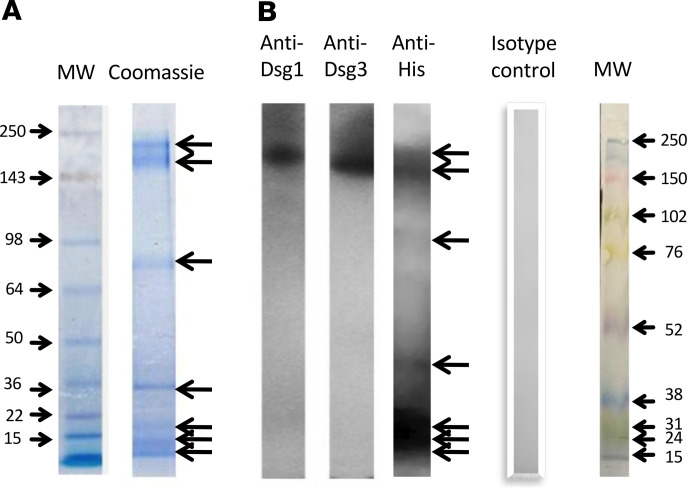
Identification of binding partners of PpSP32 by coimmunoprecipitation.The mixture of the epidermal extract and rPpSP32 was coimmunoprecipitated in the presence of magnetic beads adsorbed with anti-polyhistidine (anti-His) capture antibody. The coimmunoprecipitation (Co-IP) eluate was separated by SDS-PAGE and then analyzed by Coomassie blue staining (A) and Western blotting using monoclonal anti-human Dsg1, anti-human Dsg3, anti-His antibodies, or isotype control (B). The figure is representative of 3 independent experiments.